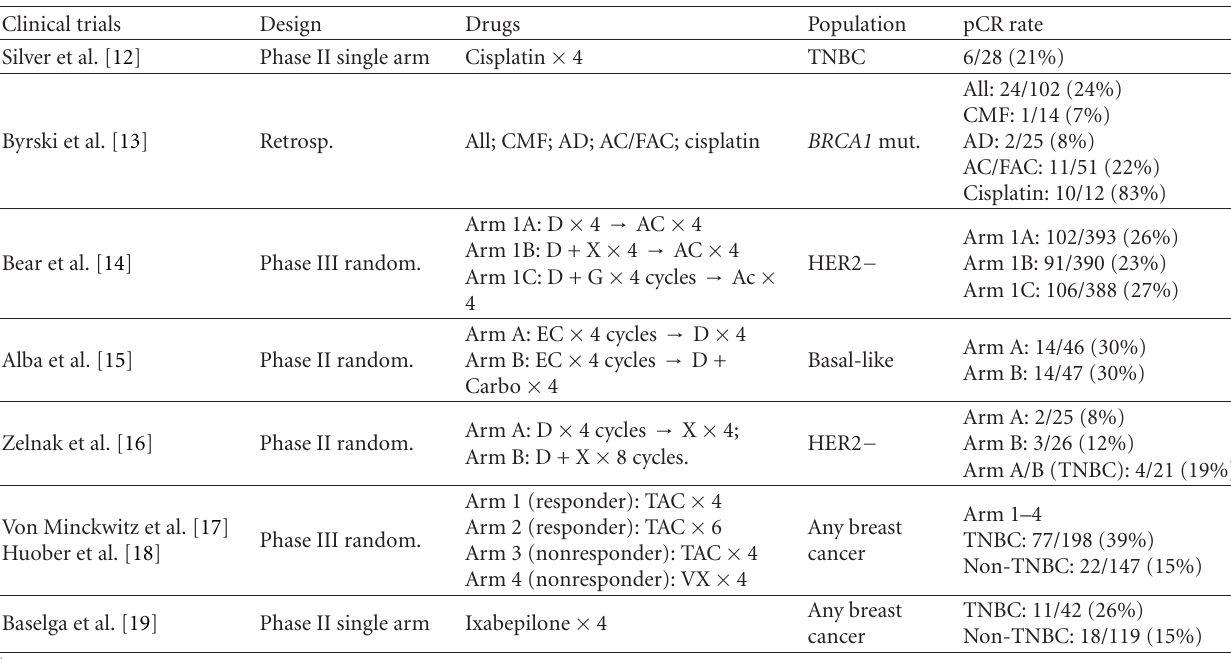
Table 1: Summary of completed neoadjuvant chemotherapy trials. ∗